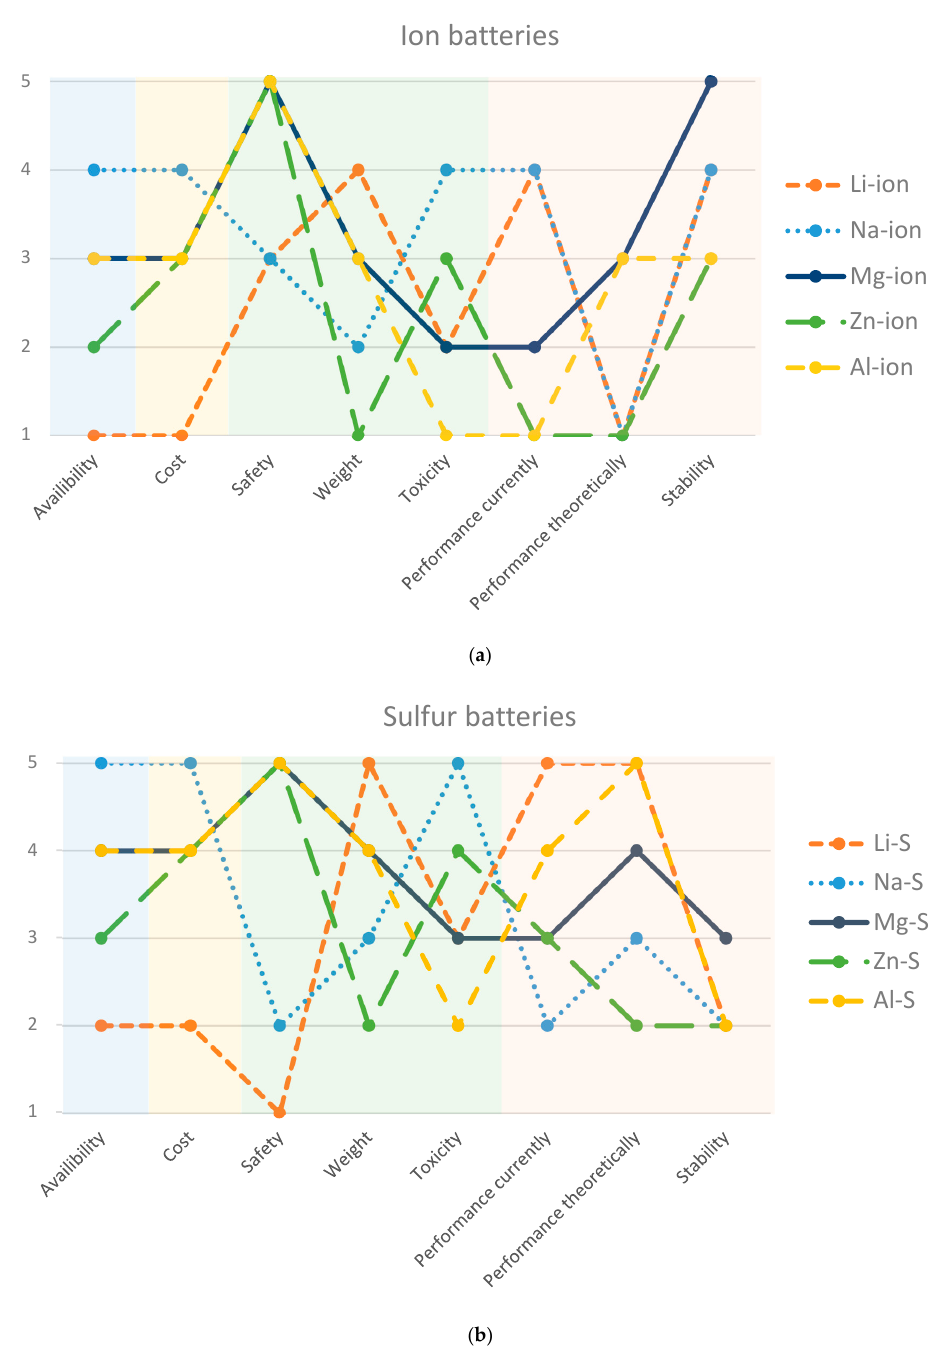
Figure 10. The point distribution outcome for the PEST analysis of the M-ion ( a ) and M-S based batteries ( b